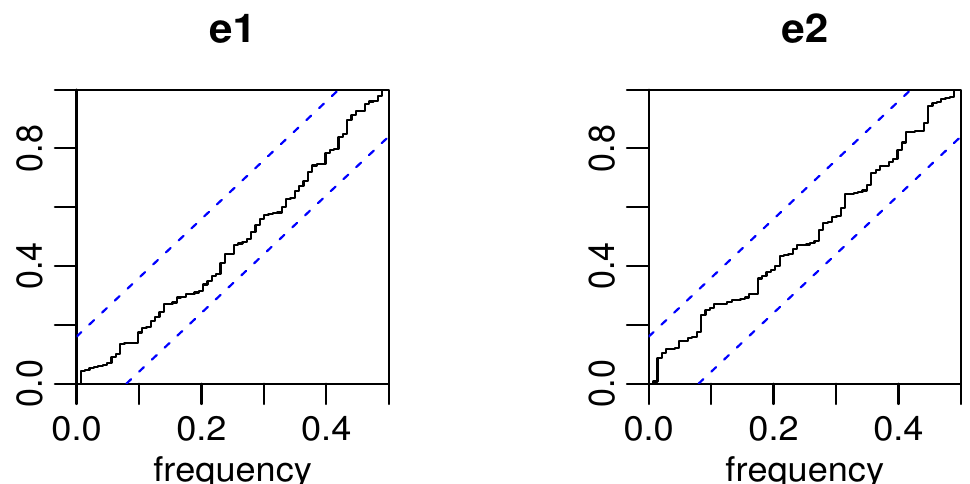
Figure 6. Cpgrams of standardized residuals of CDRUGS and CSHOTS data for BINAR(1)BP2S-L(II)